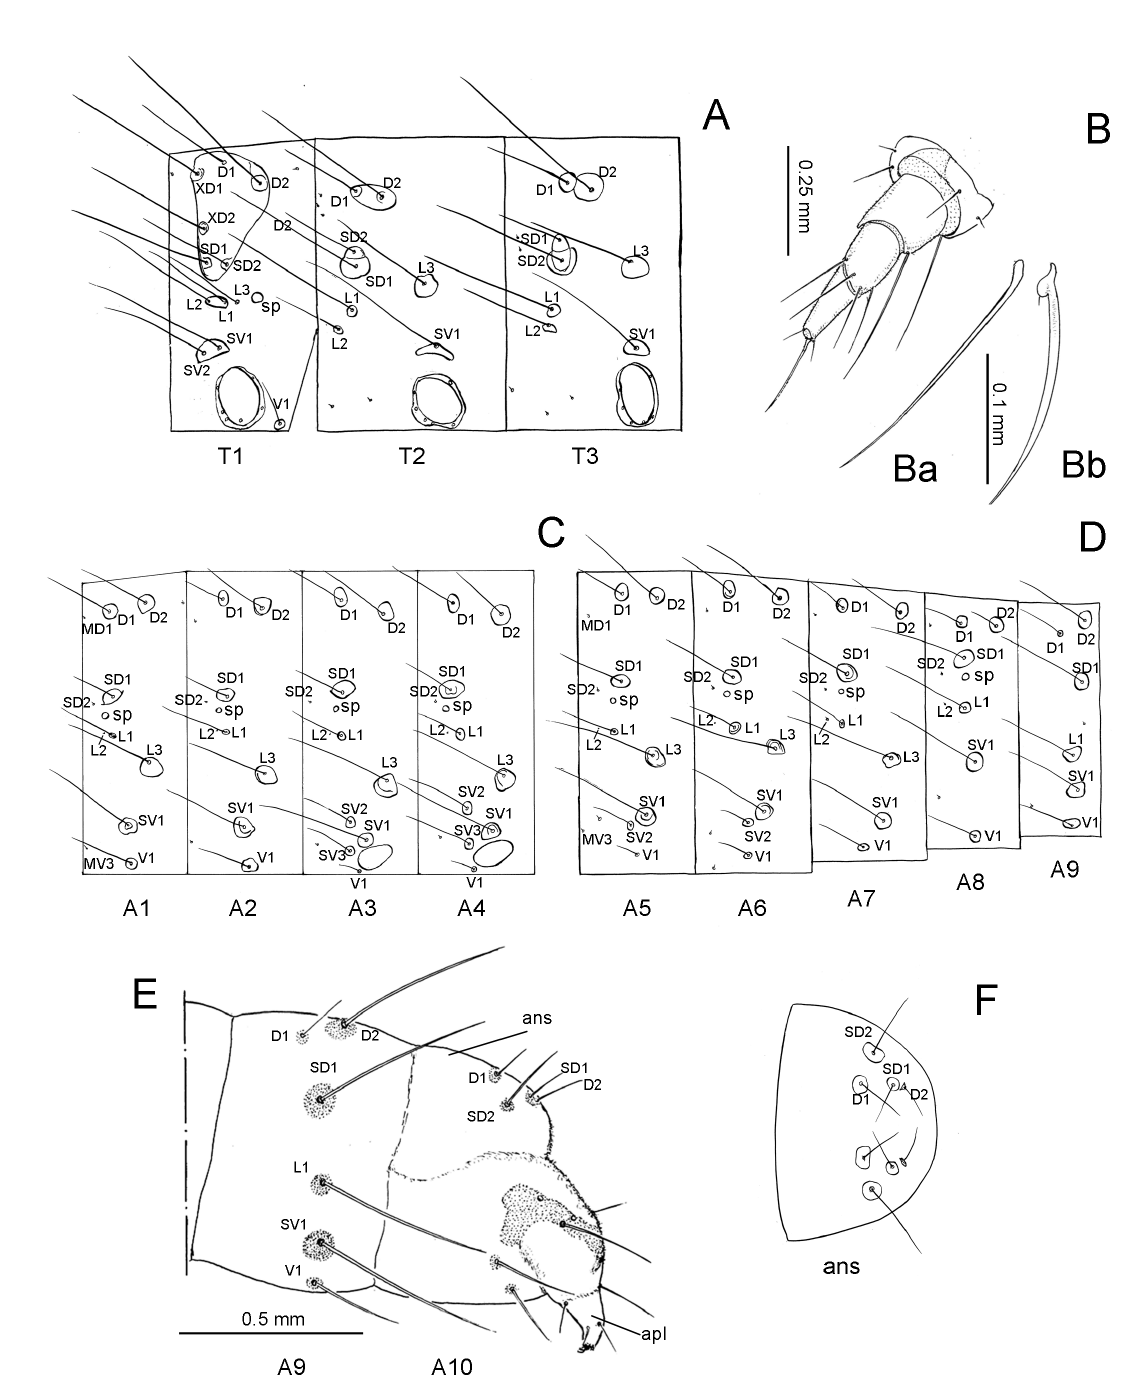
Fig. 6. Mature larval thorax and abdominal segment of Tonza citrorrhoa Meyrick, 1905 (OPU-IN- LE2018IV0031|SK600, 0025|SK603, 0026|SK604). A . Thorax segment 1–3. B . Thoracic leg on thorax segment 1. C . A 1–4. D. A5–9. E . A9–10. F . Anal shield. Abbreviations: ans = anal shield; apl = anal proleg; Ba = claw, lateral view; Bb = same, frontal view; D1, D2 = dorsal setae; L1, L2, L3 = lateral setae; MD1 = microdorsal seta; MV3 = microventral seta; SD1, SD2 = subdorsal setae; sp = spiracle; SV1, SV2, SV3 = subventral setae; V1 = ventral seta; XD1, XD2 = XD group, dorsal setae on the ante- rior margin of the